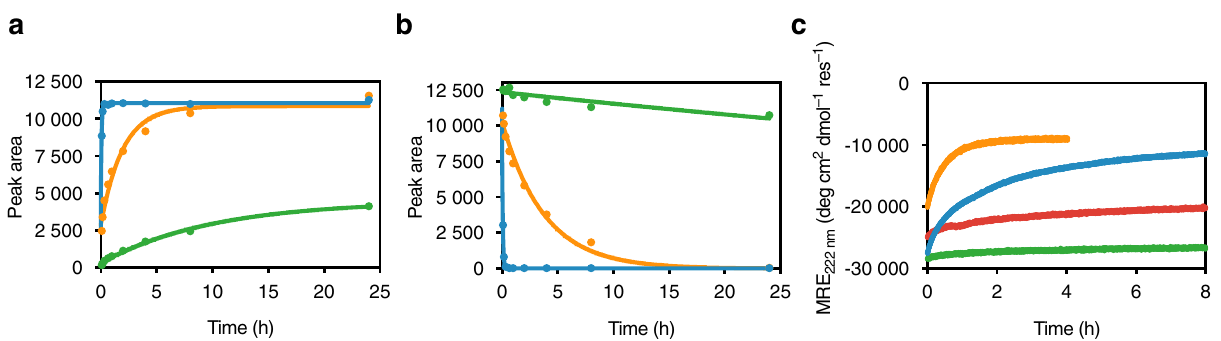
Fig. 2 Kinetics of phosphorylation-induced dissociation. Representative phosphorylation reaction time courses for a product (CC-Di-B_RRpS) formation, and b substrate (CC-Di-B_RRS) consumption, determined by analytical HPLC. Time courses are shown for reactions consisting only of CC-Di-B_RRS (blue); or CC-Di-B_RRS in the presence of CC-Di-A_S (orange) or CC-Di-A N 4 (green). c Representative phosphorylation time courses determined by CD spectroscopy for CC-Di-B_RRS in the presence of CC-Di-A_S at 25 °C and 37 °C (blue and orange) and CC-Di-A N 4 at 25 °C and 37 °C (green and red). Each peptide was at 50 µ M concentration, and reactions were performed in PBS at pH 7.4 supplemented with 10 mM MgCl 2 and 1 mM ATP. cAMP- dependent protein kinase (PKA, 8.33 U µ L − 1 of reaction) was added to initiate phosphorylation. Reactions for analytical HPLC were all performed at 25 °C. All reactions were performed in